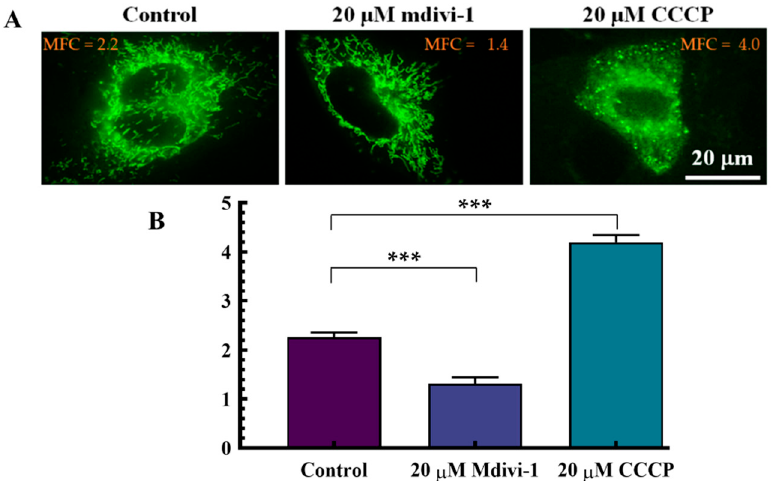
Figure 3. Cells treated with 20 µ M mdivi-1 and 20 µ M CCCP. ( A ) illustrates cells treated with 20 µ M mdivi-1 and 20 µ M CCCP and incubated for 30 min. There was a well elongated and distinct mitochondrial structure shown by cells treated with mdivi-1 but a fragmented and granular mitochondrial structure shown for CCCP treated cells compared to the control. There was a significant (*** p < 0.01) decrease in MFC (1.5 ± 0.2) of mdivi-1 treated cells compared control, but CCCP treated cells showed a very significant (*** p < 0.01) increase in MFC (4.3 ± 0.2) compared to the control shown in ( B